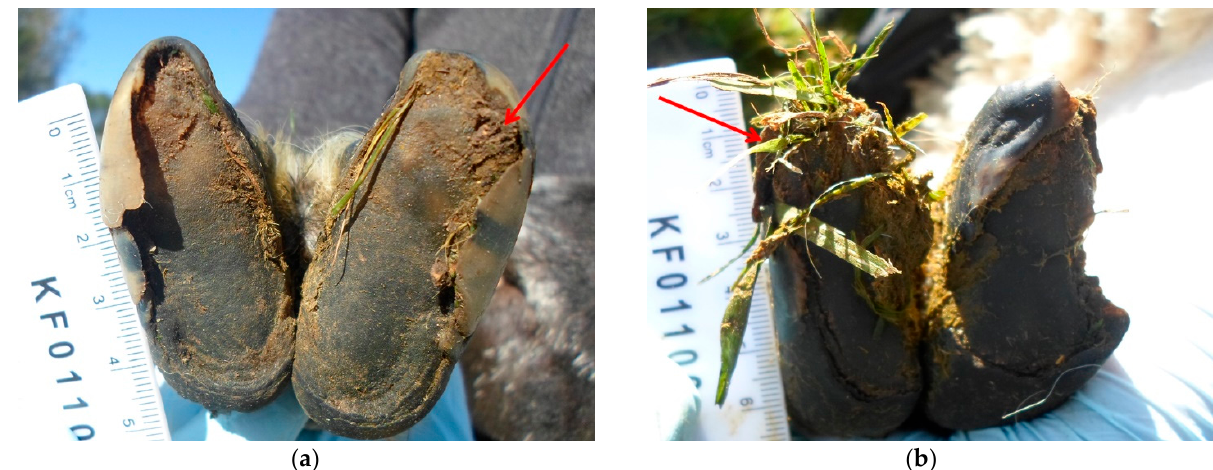
Figure 2. ( a ) Large cavity along the abaxial hoof wall impacted with soil (red arrow); ( b ) Large cavity at the toe and along the abaxial hoof wall impacted with grass and faecal material (red arrow).